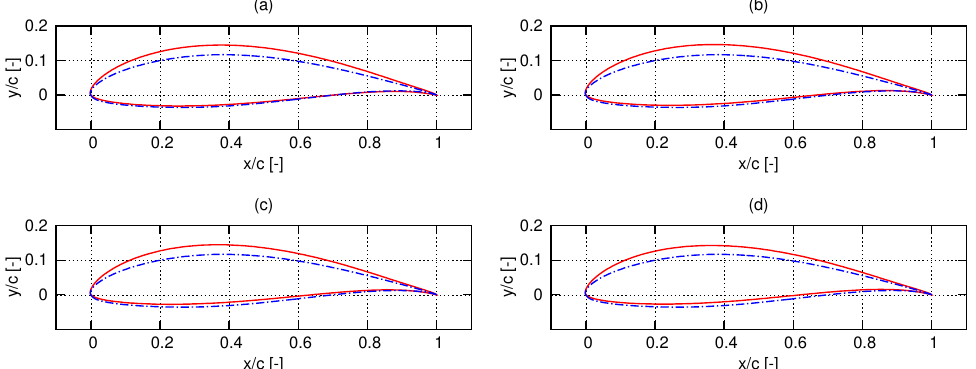
Figure 13. Reference and optimized hydrofoils of the first case of 2-D optimization, where ( a ) is optimized hydrofoil HF-2D-1-1, ( b ) is optimized hydrofoil HF-2D-1-2, ( c ) is optimized hydrofoil HF-2D-1-3 and ( d ) is optimized hydrofoil HF-2D-1-4. The red solid lines denote the optimized hydrofoil and the blue dash-dot lines denote the original